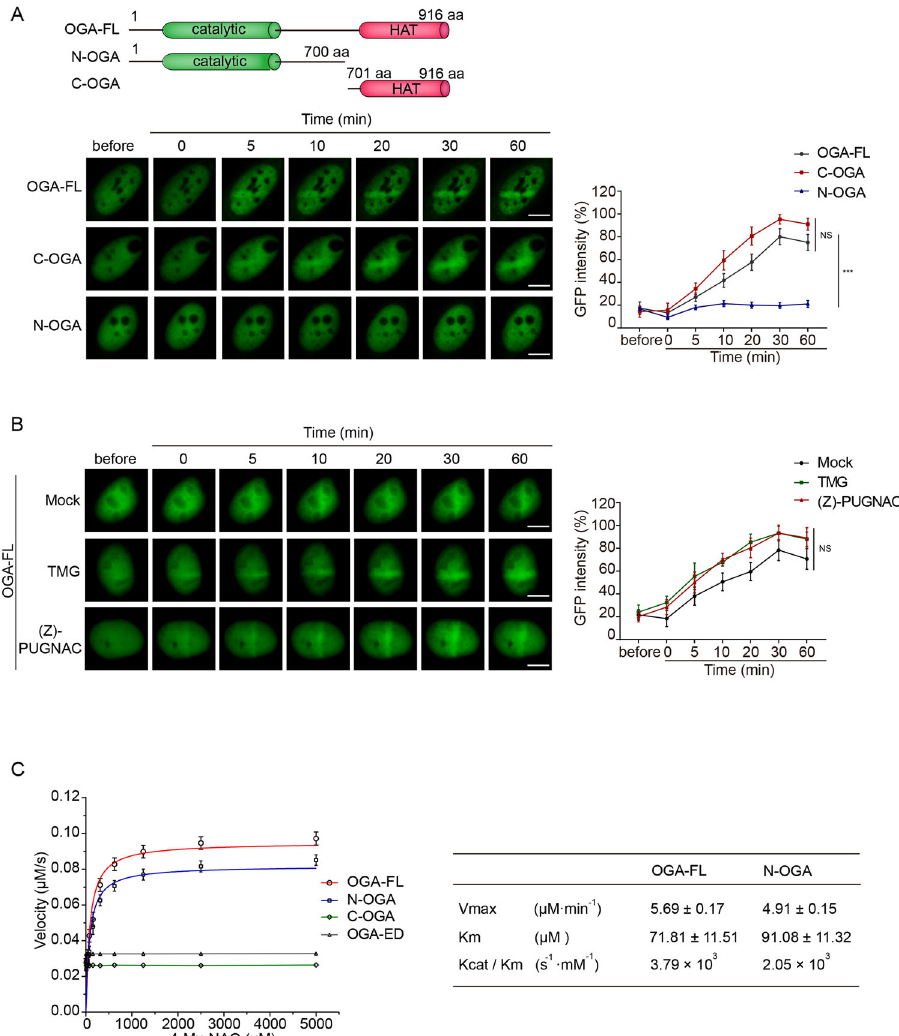
Fig. 1 The nuclear localization of OGA in response to laser microirradiation. A The HAT domain plays a key role for the OGA recruitment to DNA lesions. Upper panel: diagrams showing the OGA deletion mutants. Lower panel: The full-length OGA, C-OGA, or N-OGA were expressed in U2OS cells. The cells were treated with laser microirradiation. The recruitment kinetics of full-length OGA, C-OGA, and N-OGA to laser strips were examined by measuring the peak fl uorescence density of OGA at the laser strips at indicated time points using Image J (right panel). Scale bar: 5 μ m. B Suppression of OGA ’ s enzymatic activities does not affect the recruitment of OGA. U2OS expressing full-length OGA were treated with OGA inhibitors ((Z)-PUGNAC (50 μ M) or TMG (10 μ M) for 24 h and then were subjected to laser microirradiation. The peak fl uorescence density of OGA at the laser strips was quanti fi ed at indicated time points by Image J (right panel). Scale bar: 5 μ m. C Michaelis – Menten kinetics of full-length OGA (OGA-FL), N-OGA, C-OGA, and OGA-ED. 4-Mu-NAG was incubated with recombinant OGA or its truncation mutants in the in vitro deglycosylation assays. The enzymatic parameters are: OGA-FL, Vmax = 5.69 ± 0.17 μ M min − 1 , Km = 71.81 ± 11.51 μ M and Kcat/Km = 3.79 × 10 3 (s − 1 mM − 1 ); N-OGA, Vmax = 4.91 ± 0.15 μ M min − 1 , Km = 91.08 ± 11.32 μ M and Kcat/Km = 2.05 × 10 3 (s − 1 mM − 1 ). Data were fi tted using GraphPad Prism. Error bars represent ± SEM values derived from three independent